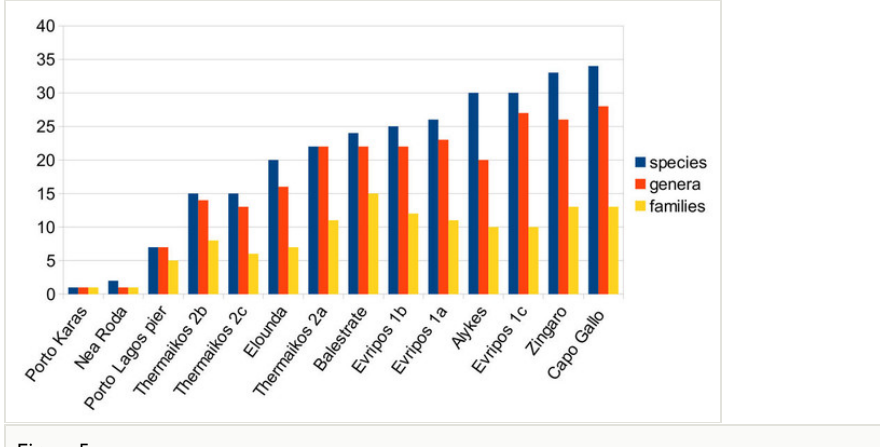
Figure 5. Number of species, genera and families per sampling location. Diagram based on the data from Suppl. material